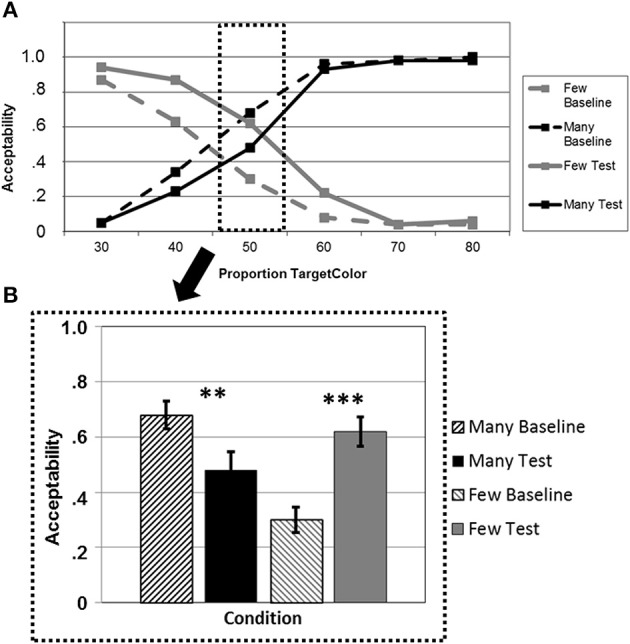
(A) Average acceptability ratings for a given proportion of circles of the mentioned color, plotted separately for the quantifiers “many” (black lines) and “few” (gray lines) in the baseline blocks (dashed lines) and the test blocks after adaptation (solid lines). (B) Average acceptability ratings for a critical proportion of circles of the mentioned color, plotted separately for “many” (black bars) and “few” (gray bars) in the baseline blocks (dashed bars) and the test blocks after adaptation (solid bars). **p < 0.01, ***p < 0.001.